Question: What type of chart is this?
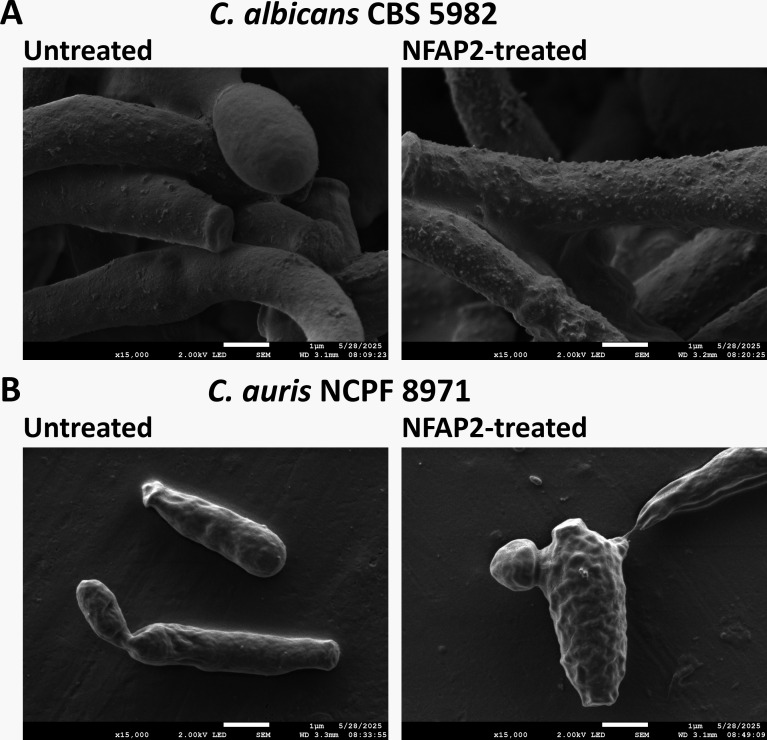
Answer: line